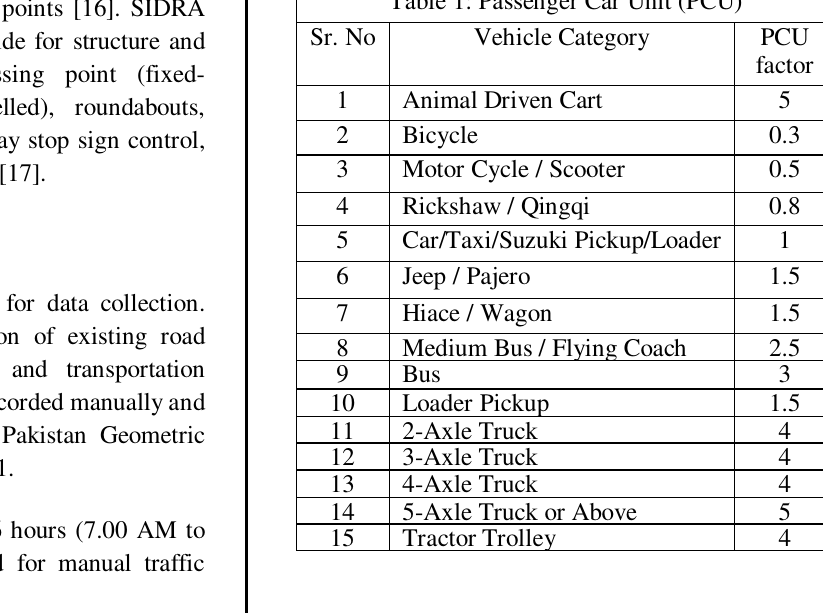
Table 1: Passenger Car Unit